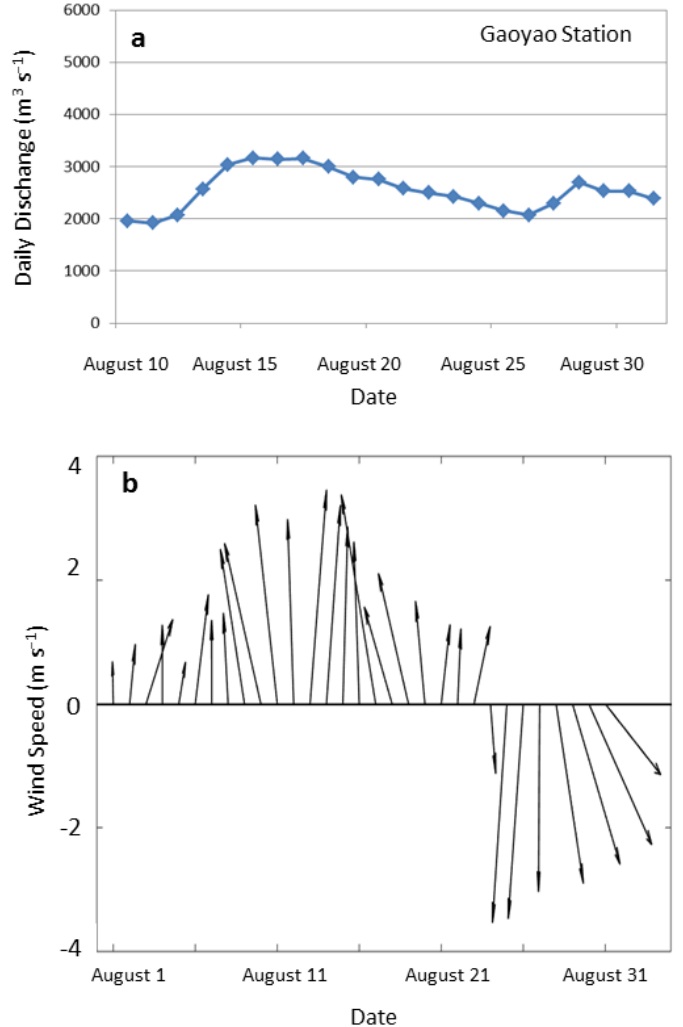
Figure 3. Daily discharge from Pearl River at Gaoyao Station ( a ), and wind speed and direction collected for the Pearl River Estuary ( b ), August 2011.